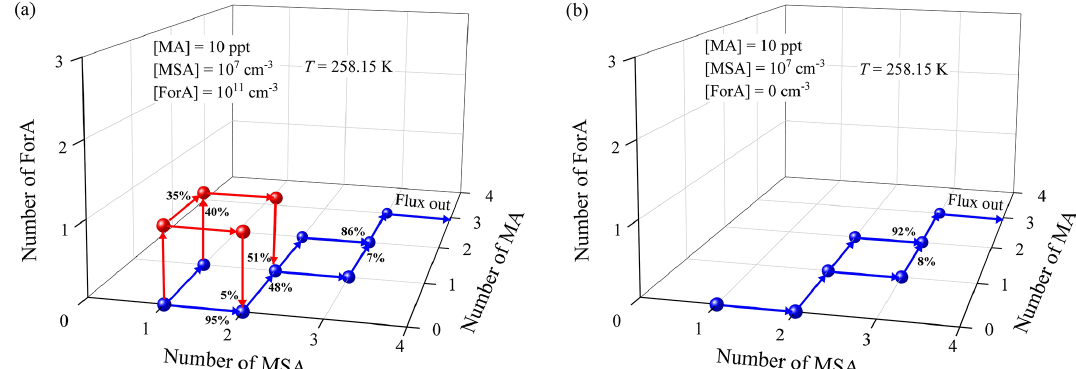
Figure 6. Main cluster formation pathways for the ternary MSA–MA–ForA system (a) and the MSA–MA system (b) at T = 258 . 15K, [MA] = 10ppt, [MSA] = 10 7 , and [ForA] = 10 11 moleculescm − 3 (only for the ternary MSA–MA–ForA